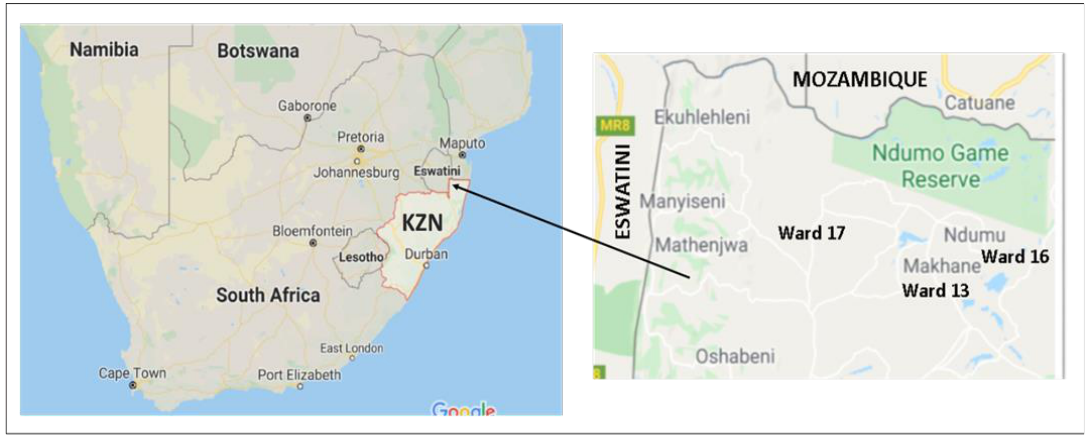
Figure 1. The map of South Africa showing Ingwavuma rural community in north-eastern KwaZulu-Natal (KZN). Source: Google Maps.